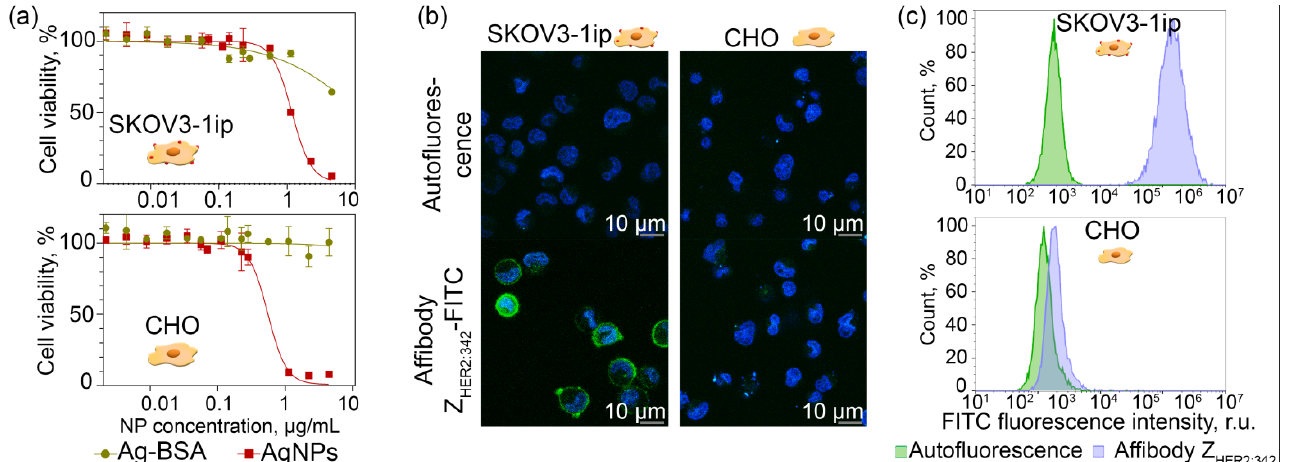
Figure 3. Protein-mediated shielding of Ag NP cytotoxicity. Affibody Z HER2:342 cell labeling. ( a ): MTT assay results of the SKOV3-1ip and CHO cells viability (%) depending on the concentration of un- modified Ag NPs and BSA-modified Ag-BSA NPs in the medium (μg/mL). ( b ): Confocal microscopy of HER2-overexpressing SKOV3-1ip and HER2-negative CHO cells labeled with Z HER2:342 -FITC. ( c ): Flow cytometry histograms of SKOV3-1ip and CHO cells showing the cell interaction with Z HER2:342 -FITC. Green—cell autofluorescence, blue—cells labeled with affibody.